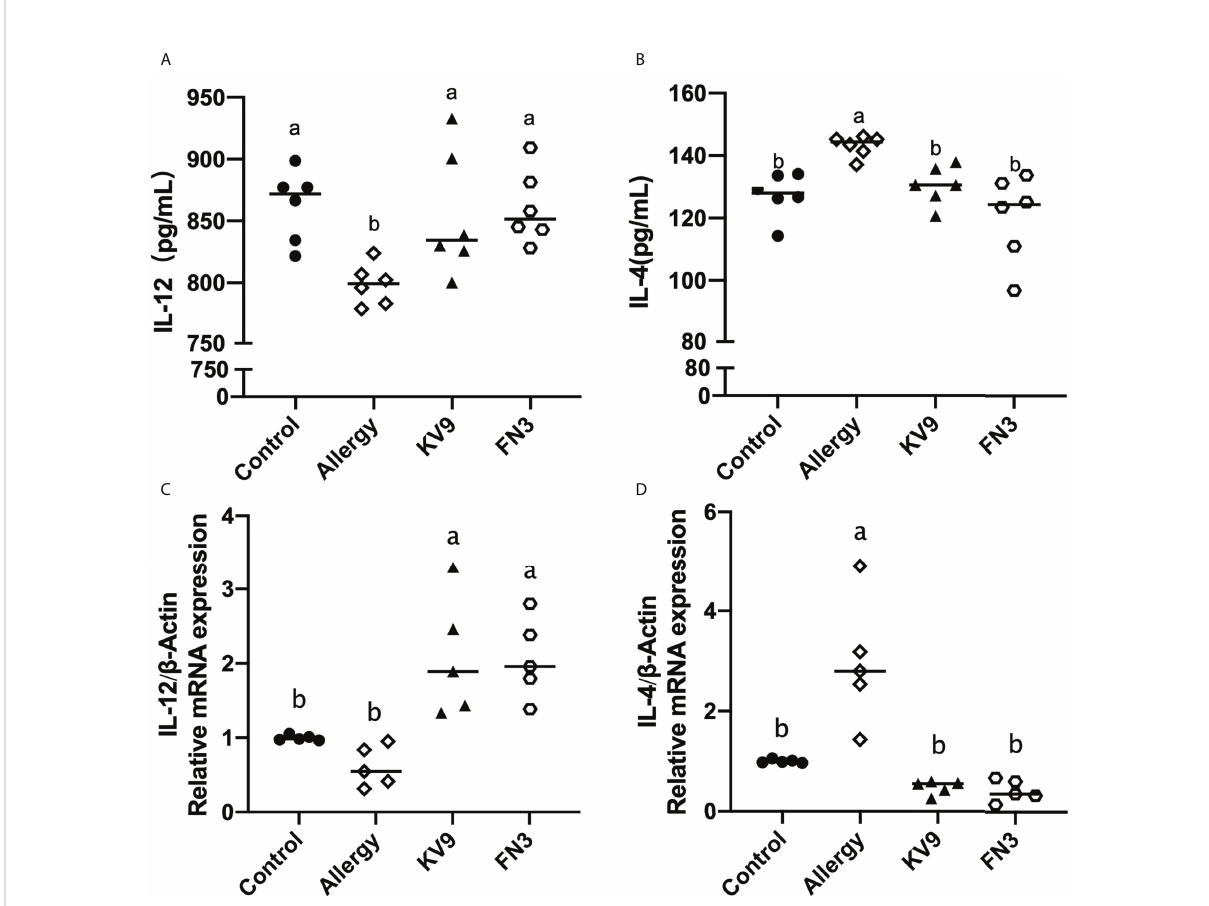
FIGURE 6 The IL-12 (A) and IL-4 (B) cytokine levels secreted from DCs and gene expression of IL-12 (C) and IL-4 (D) in DCs of each group of mice. Identical lowercase in the fi gure indicates the lack of signi fi cance ( p <